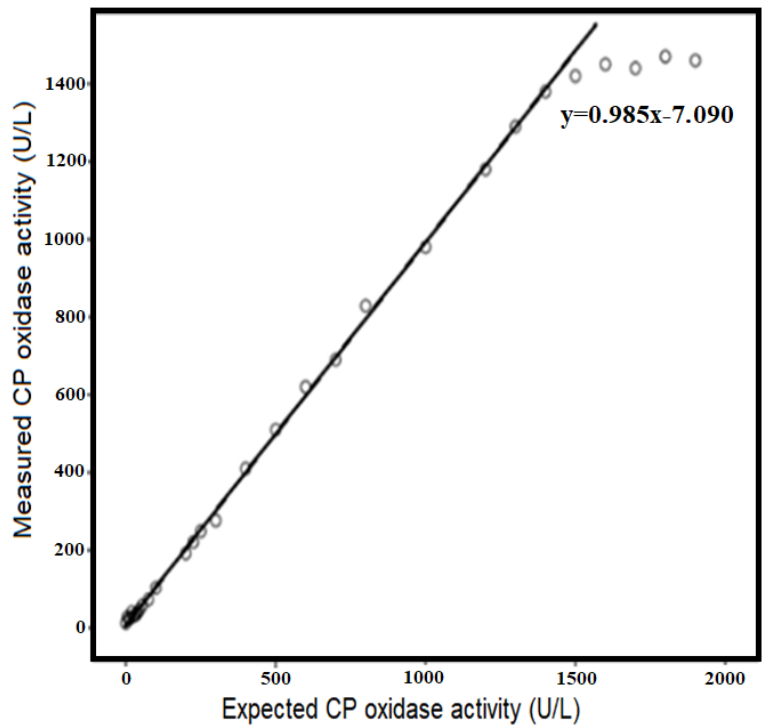
Figure 1. The regression line of the new method showing the linearity of CP oxidase activity using human ceruloplasmin.